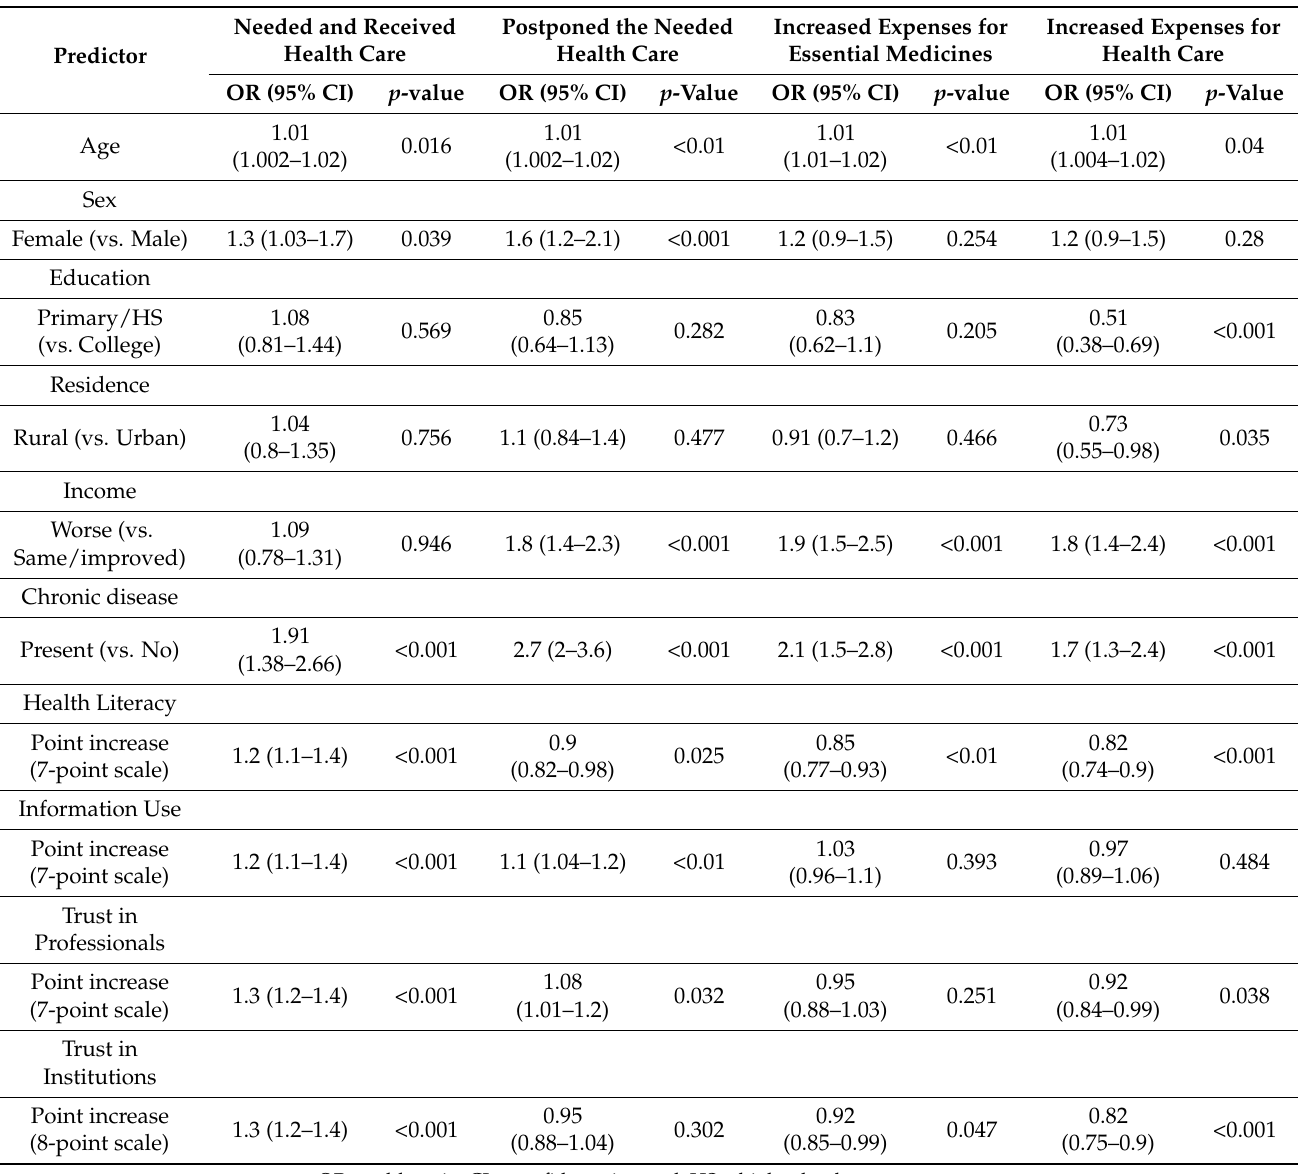
Table 6. Associations between selected endpoints of barriers of access to care, postponements of care, and increased expenses for medicines and health care with relevant predictors; crude odds ratios with 95% confidence